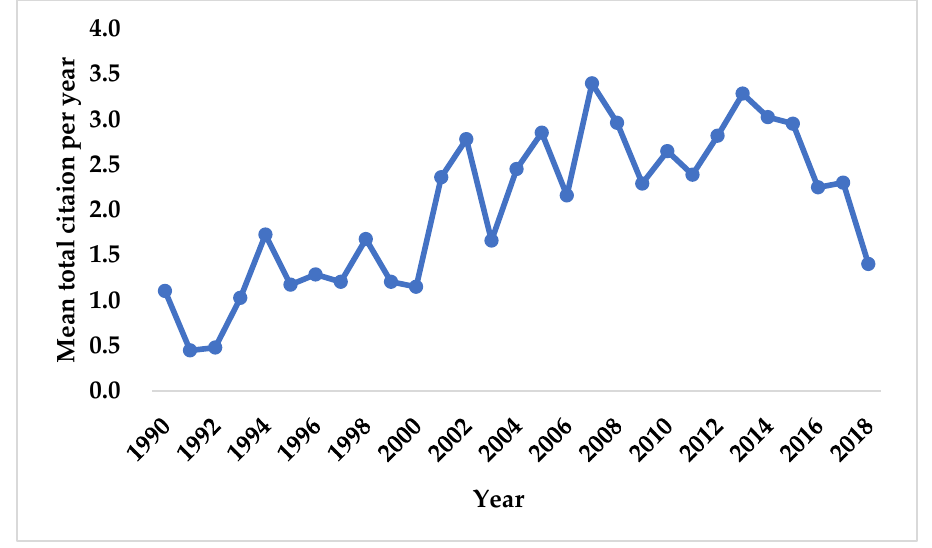
Figure 3. The number of annual cited paper.